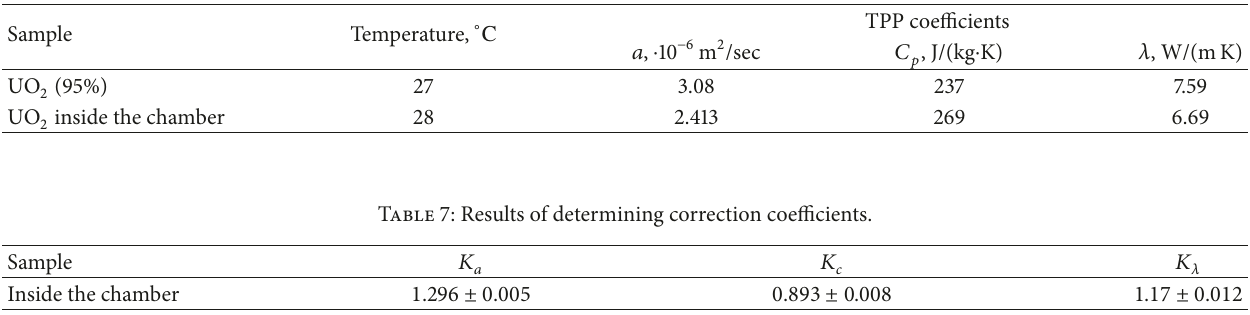
Table 6: TPP values of the samples for U \ 2 samples series.